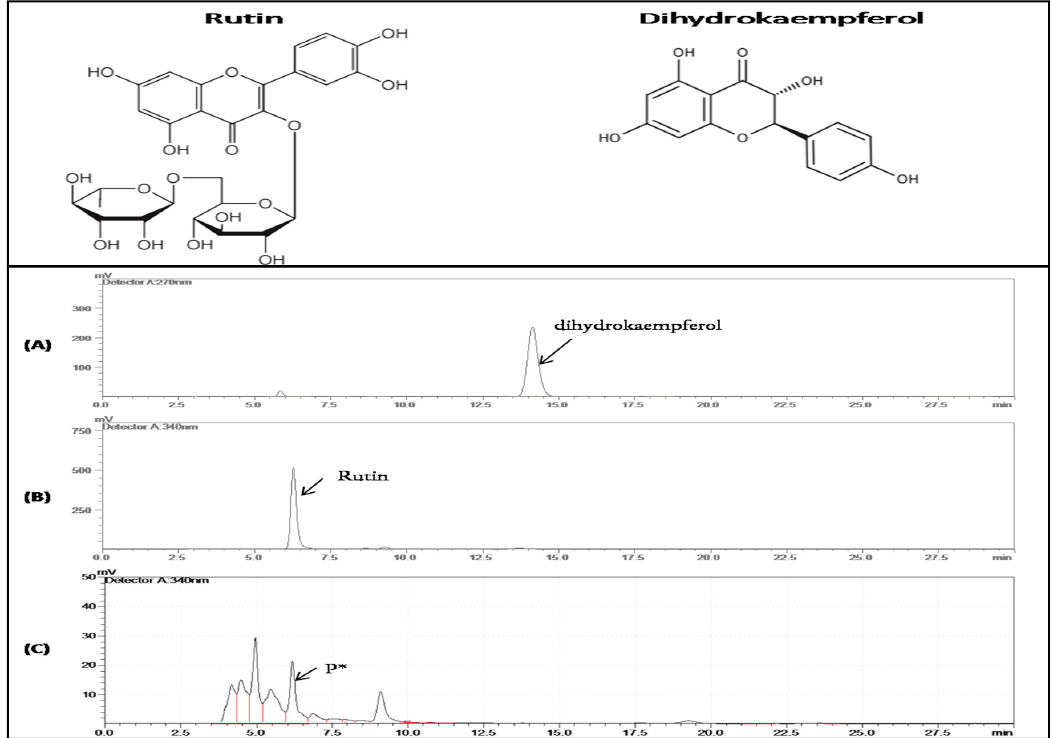
Figure 3. The chemical structure of rutin and dihydrokaempferol metabolites and their in vitro enzymatic activity and a high-performance liquid chromatography (HPLC) profile against the purified recombinant CtCYP82G24 protein. The protein extract was monitored at 415 nm on an Agilent Zorbax SB-C 18 column (4.6 × 150 mm, 5 μ m) with methanol:acetonitrile (v:v of 1:10) as mobile phase A and 0.4% phosphoric acid as phase B. The metabolites were quantified using the aluminum chloride colorimetric method described by [35]. The total metabolite content was expressed as milligrams of rutin equivalent (CE) per 100 g dry weight (DW). ( A ) Peak labelled dihydrokaempferol and ( B ) peak marked as rutin was used as the authentic standards. ( C ) HPLC profile of the reaction product P* catalyzed by CtCYP82G24. The retention times of rutin and product P* showed close proximity in peak 4, which was approximately 6.3 min.